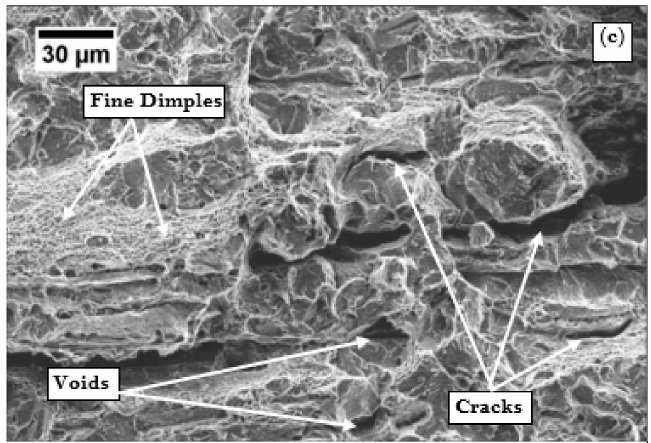
Figure 9. SEM fractography images of impact samples of boron steel: ( a ) conventional heat-treated (900 ◦ C / 0.67 h, water-quenched), ( b ) conventional heat-treated (900 ◦ C / 0.67 h, water-quenched) + deep